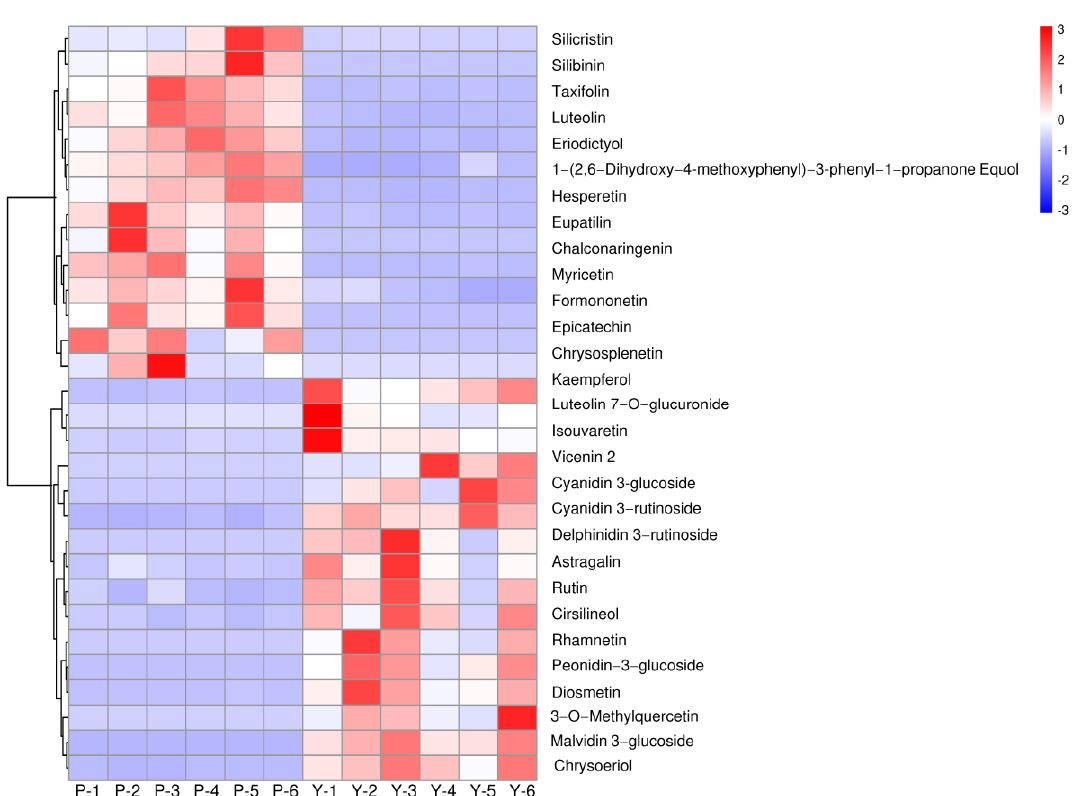
Figure 3. Heat maps of flavonoid biosynthesis metabolites in the bark (P) and leaves (Y) of H. chrysantha . Blue, white, and red indicate low, intermediate, and high expression, respectively.